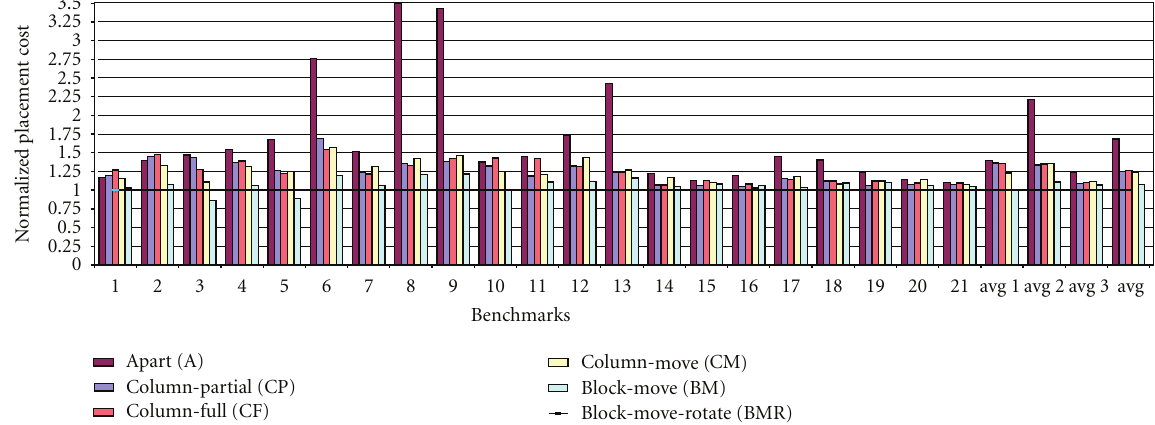
Figure 10: Placement cost comparison between di ff erent techniques of mesh-based architecture.